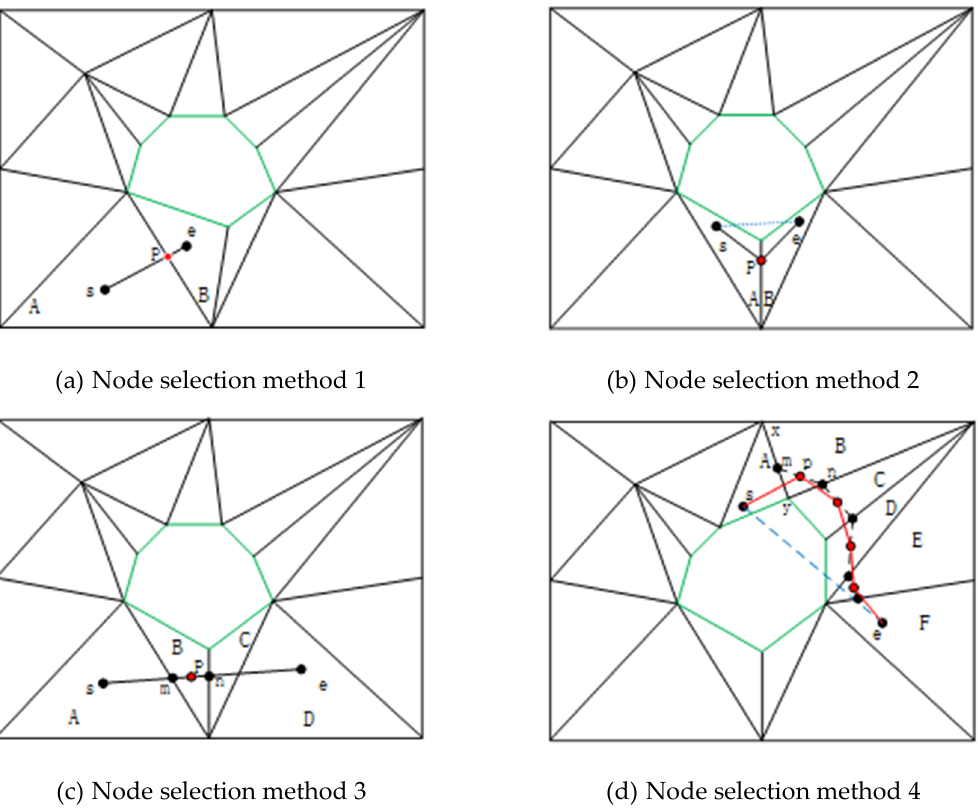
Figure 17. Node selection algorithm diagram.